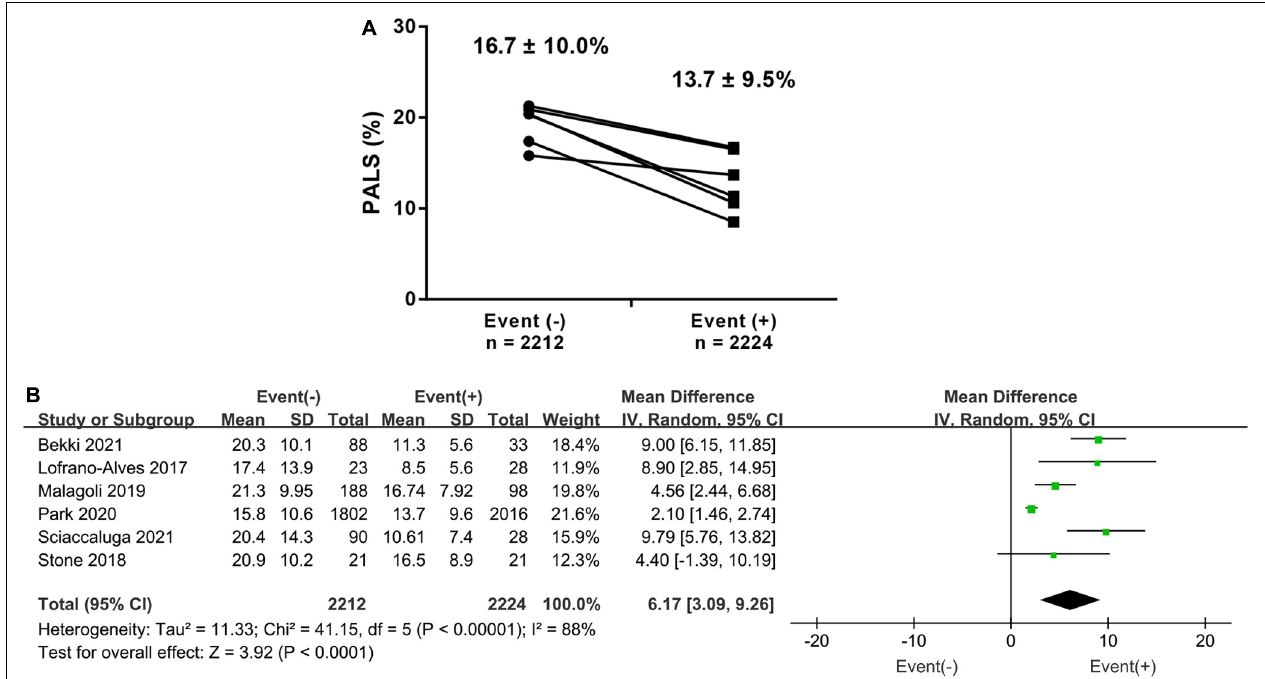
FIGURE 2 | (A) Baseline difference (mean ± SD) of PALS in heart failure (HF) patients with endpoints and those without endpoints. (B) The forest plot shows a weighted mean difference and 95% CI of baseline peak atrial longitudinal strain (PALS) between the above two groups.